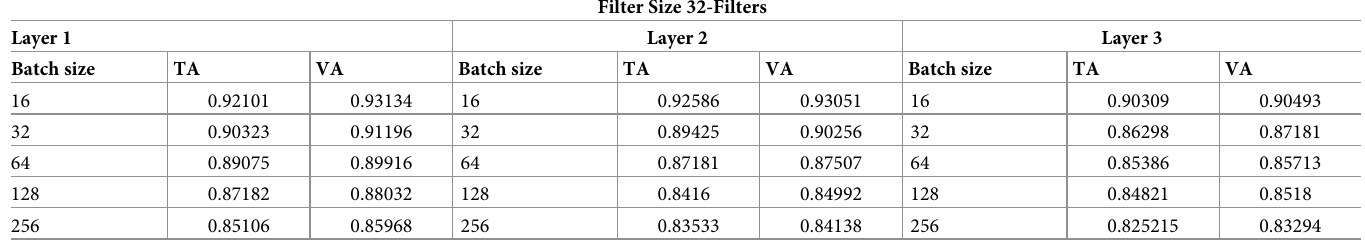
Table 4. Experimentation results of LSTM with 32-Filters.